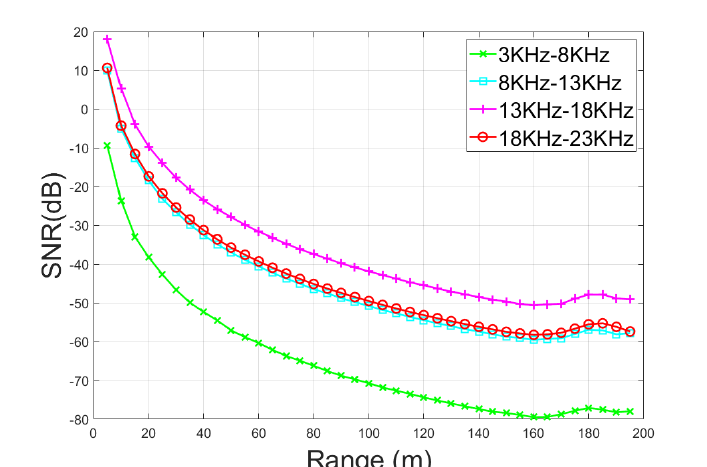
Figure 9. SNR of frequency band 3 kHz–8 kHz, 8 kHz–13 kHz, 13 kHz–18 kHz and 18 kHz–23 kHz. The 13 kHz–18 kHz band has the best SNR